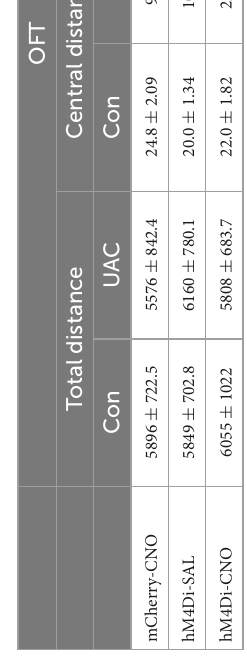
In the hM4Di-induced Vpdm VGLUT1 inhibition experiment, six UAC mice were randomly divided into hM4Di-Saline- treated ( n = 3) and hM4Di-CNO-treated groups ( n = 3). The activity of the hM4Di-labeled neurons was verified by the ratio of the number of c-FOS/mCherry double-stained neurons to the number of mCherry-containing neurons (c- FOS + mCherry/mCherry). To verify the specificity of the VGLUT1:tdTomato mouse experiment, three mice were used in FISH evaluations. Six VGLUT1:tdTomato mice were randomly divided into 2-week control and UAC groups ( n = 3/group). The activation of Vpdm VGLUT1 neurons and the Vpdm VGLUT1 -VPM pathway was indicated by higher c-FOS + tdTomato/tdTomato ratios (the ratio of c-FOS/tdTomato double-labeled neurons to mCherry-labeled neurons) and c-FOS + tdTomato + FG/FG ratios (the ratio of c-FOS/tdTomato/FG triple-stained neurons to FG-labeled neurons) in 2-week UAC mice. In the activation of the Vpdm-VPM pathway via hM3Dq virus experiments, 6 control mice were randomly divided into hM3Dq-Saline-treated ( n = 3) and hM3Dq-CNO-treated groups ( n = 3). A higher ratio of c-FOS/mCherry double-stained neurons to mCherry- labeled neurons (c-FOS + mCherry/mCherry) was observed after CNO injection. In the above experiments, the brain slices (25 µ m/slice) were collected sequentially in a six-well plate (about 5 slices in each well, 6 wells). For these counts, 5 brain slices covering the Vpdm from one well were selected and summarized as data for each